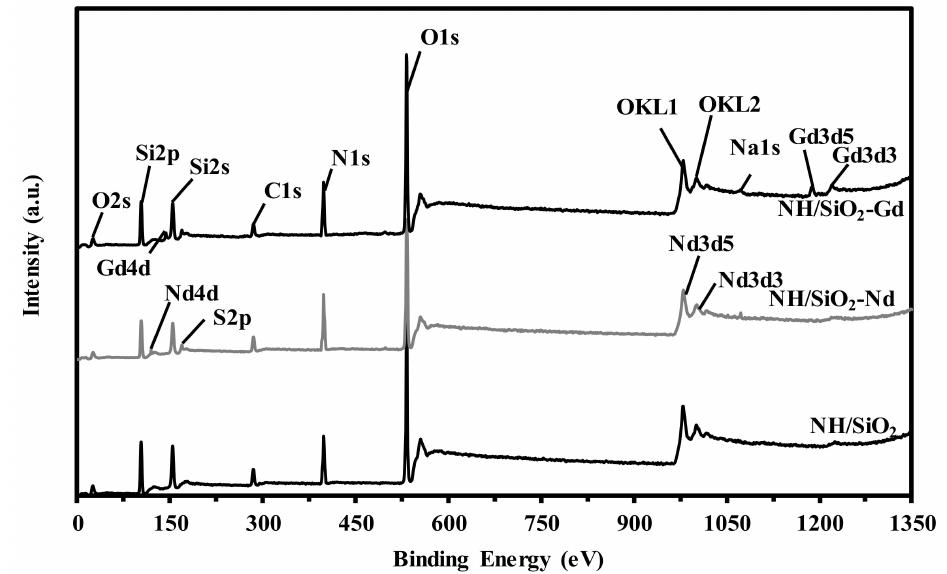
Figure 3. XPS spectra (survey) of silica functionalized sorbent (NH/SiO 2 ) before and after sorption of Nd(III) and Gd(III)